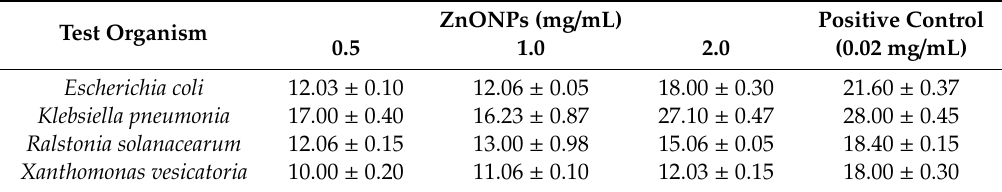
Table 2. The well di ff usion assay at di ff erent ZnONP concentrations after 24 h incubation at 37 ◦ C.